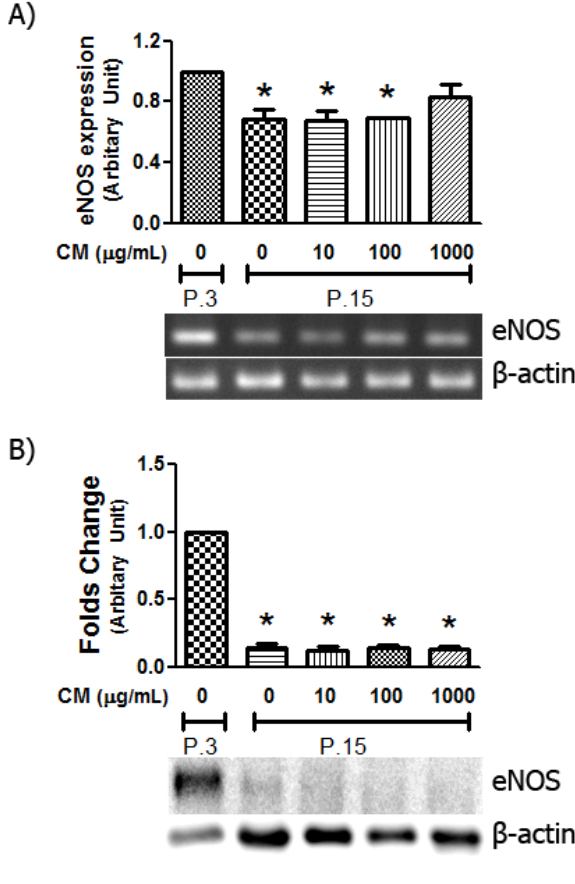
Figure 6. Influence of CM on eNOS expression. The expression of eNOS mRNA and protein were evaluated by reverse transcription-polymerase chain reaction (RT-PCR) and Western blot analysis, respectively. ( A ) Semi-quantitative eNOS mRNA expression was evaluated using specific eNOS primer and normalized to the house keeping gene β-actin as described in Materials and Methods. ( B ) The relative eNOS protein expression in HUVECs at late passage was compared to passage 3 (P.3). * p < 0.05 vs.